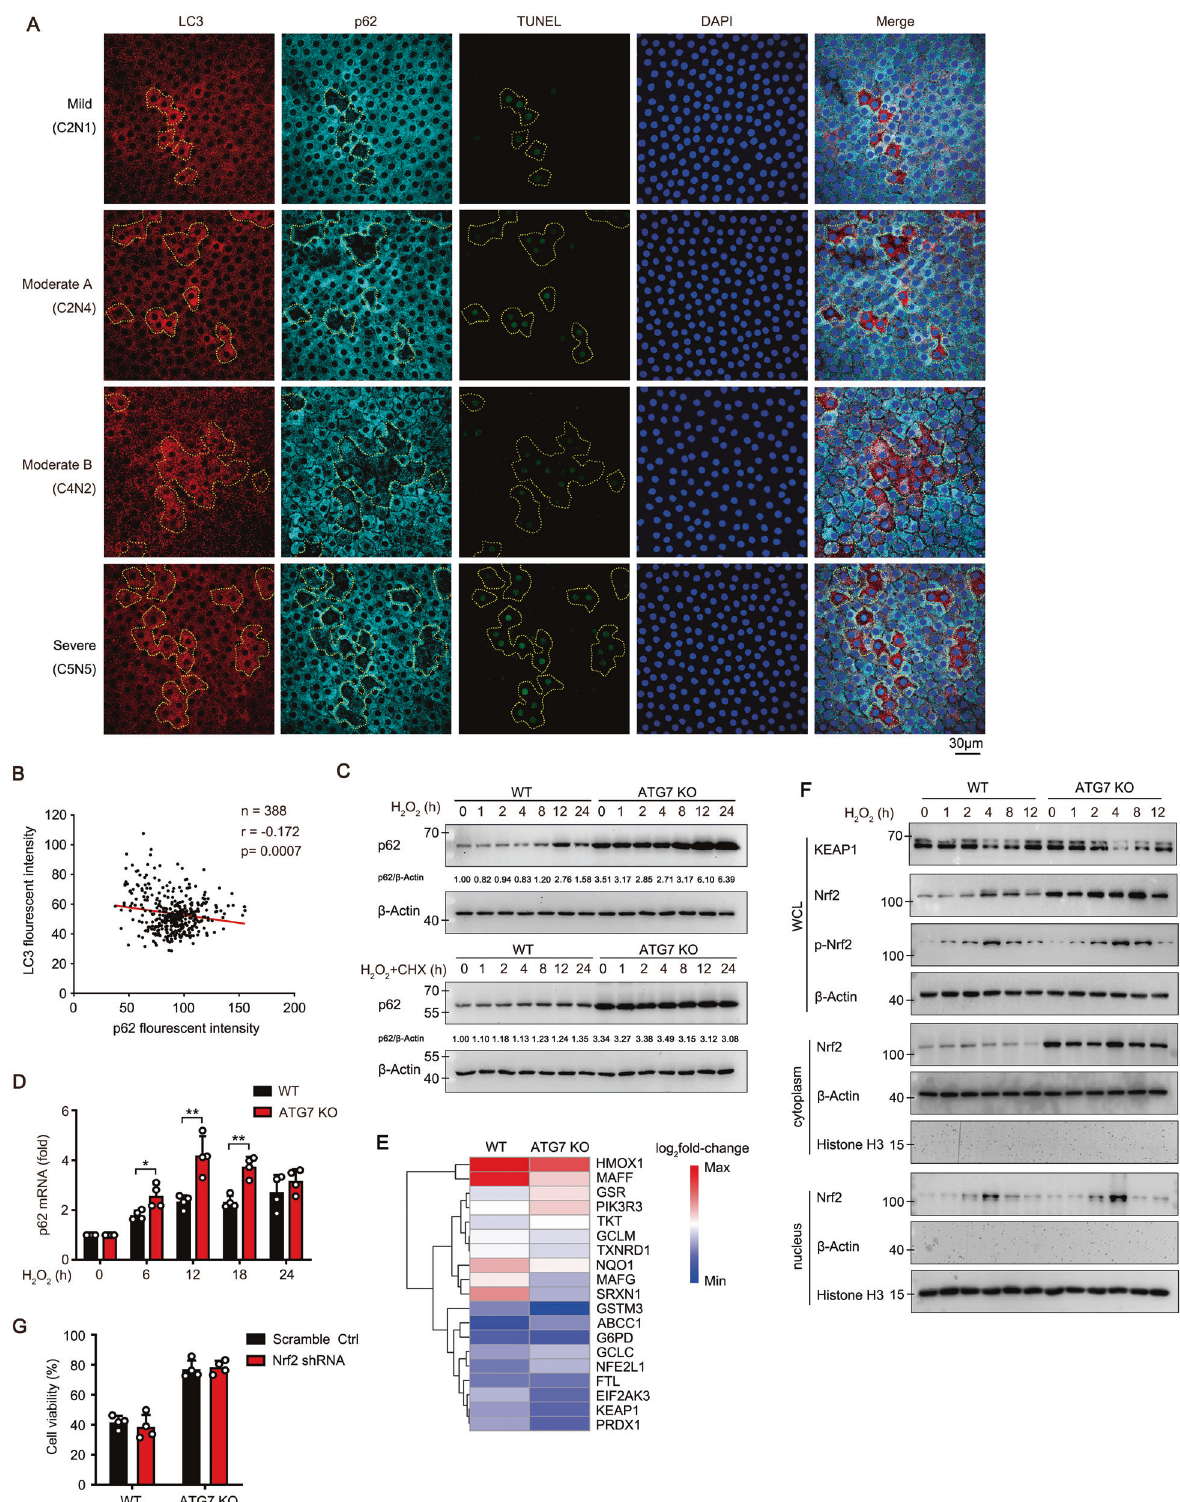
the degradation of p62 protein at 3 h and 24 h after H 2 O 2 stimulation (Fig. 7D – F). Hence, the apoptosis of elder LECs was effectively inhibited at 24 h after H 2 O 2 stimulation (Fig. 7G). These data suggested autophagy was a potential target for controlling apoptosis in senescent